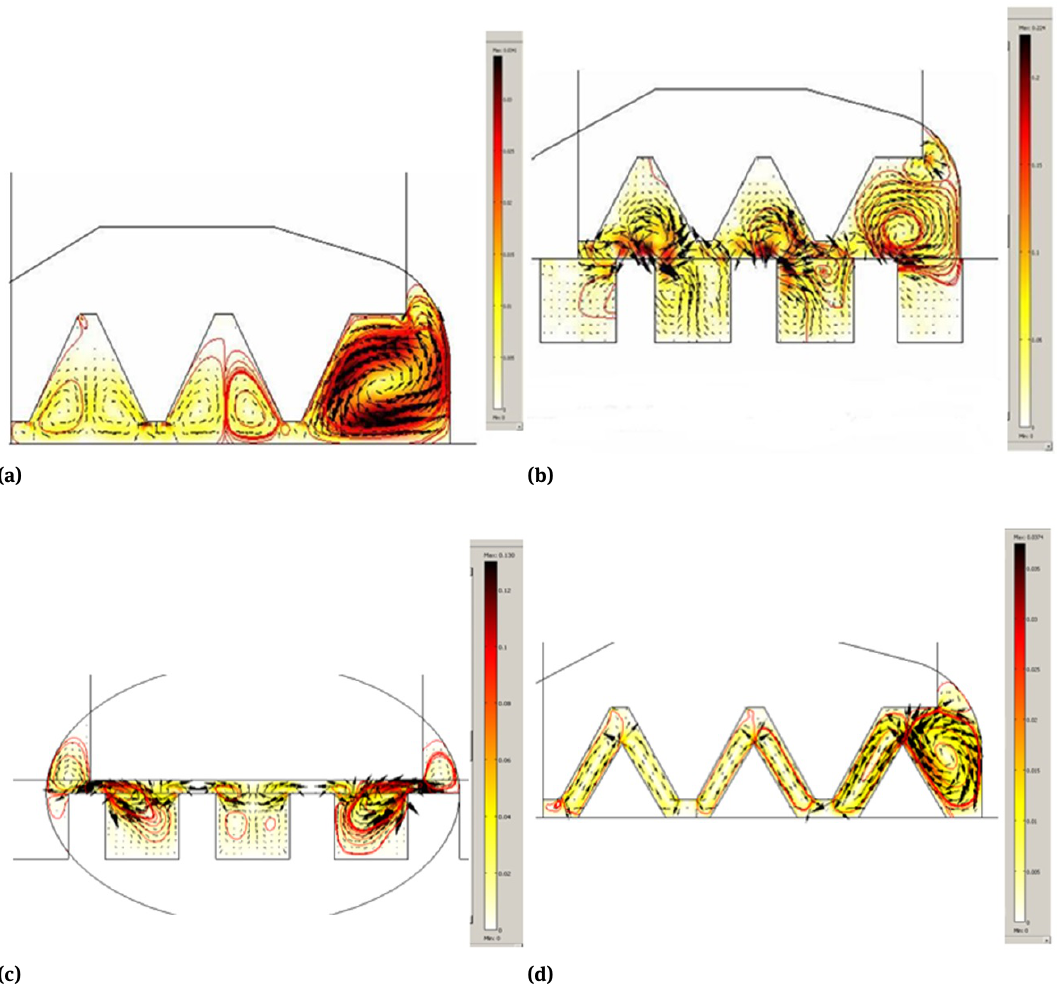
√︀ u 2 r + u 2 z , in colour